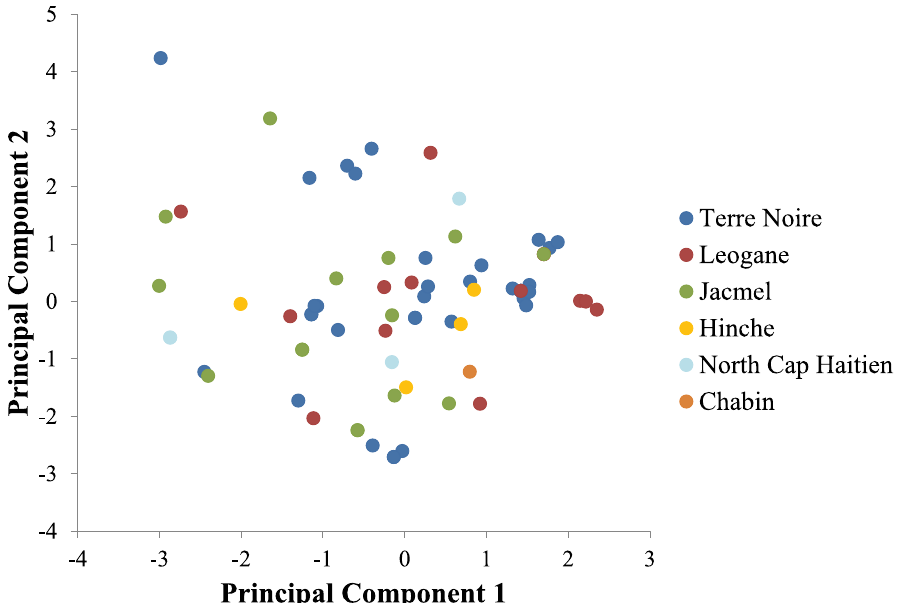
Fig 3. Plot of the first two principal components of principal component analysis, color coded by study